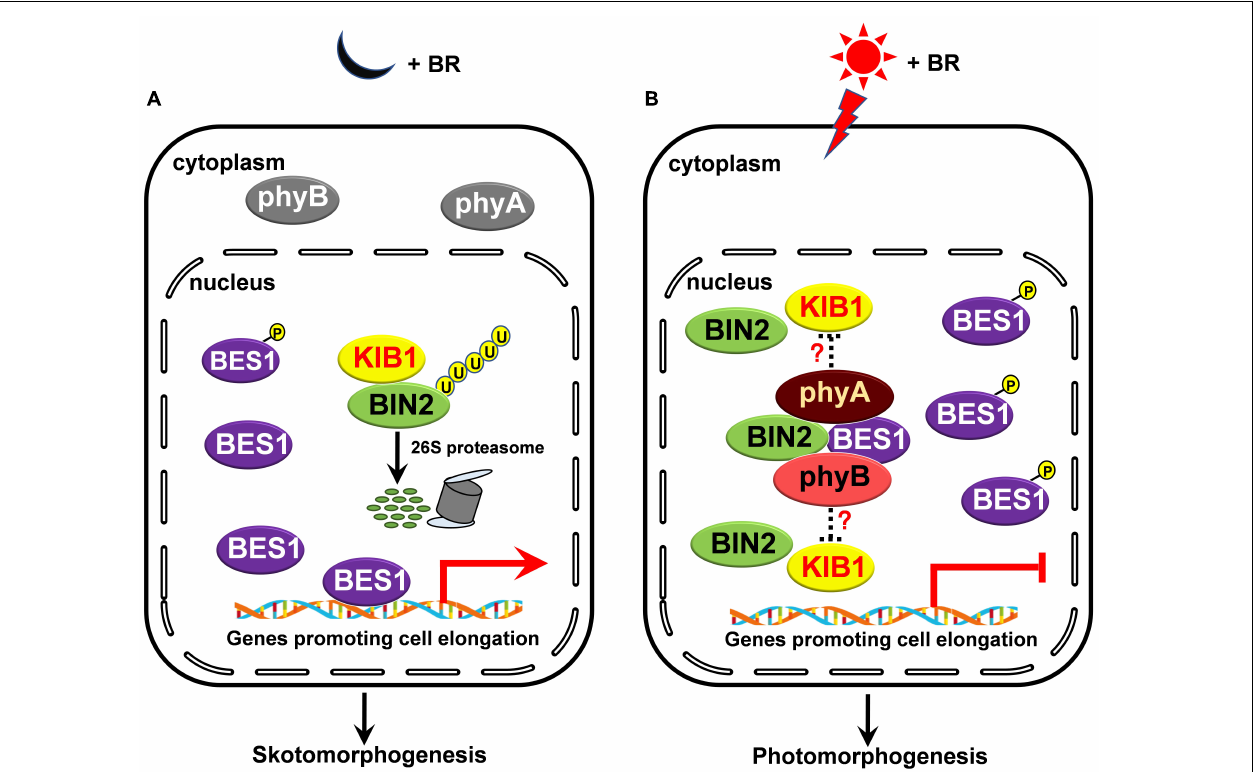
FIGURE 7 | A model illustrating how phyA and phyB may inhibit BL-induced degradation of BIN2 protein and BR signaling. (A,B) In darkness and in the presence of BR, phyA and phyB are inactive in the cytoplasm and unable to interact with BIN2 and BES1 proteins. BIN2 is ubiquitinated by KIB1 and degraded through the 26S proteasome, thus BES1 is dephosphorylated, and able to bind to its target genes to promote their expression and skotomorphogenesis (A) ; upon light irradiation, phyA and phyB are activated, and then translocated into the nucleus. We speculate that the interactions of phyA and phyB with BIN2 in light may promote the dissociation of BIN2 from its E3 ligase, such as KIB1, to stabilize BIN2 and enhance the interaction of BIN2 with BES1. Consequently, the phosphorylation of BES1 is promoted and its binding to its target genes is repressed, thus BR signaling is inhibited and photomorphogenesis is promoted (B)